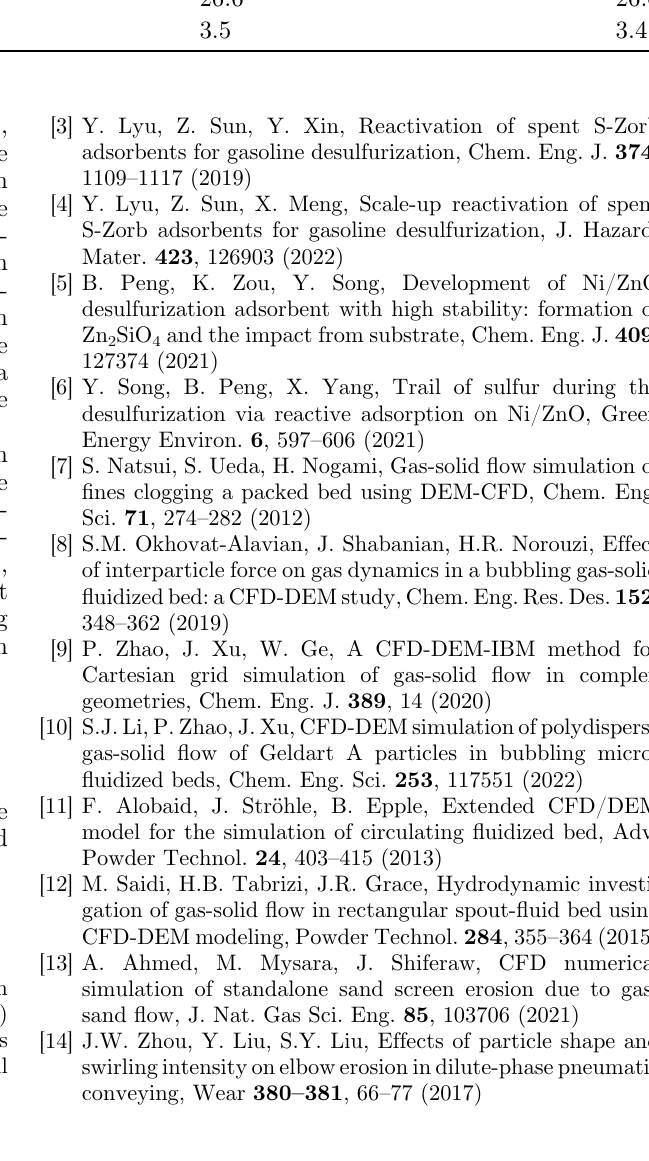
Table 6. Orthogonal test R